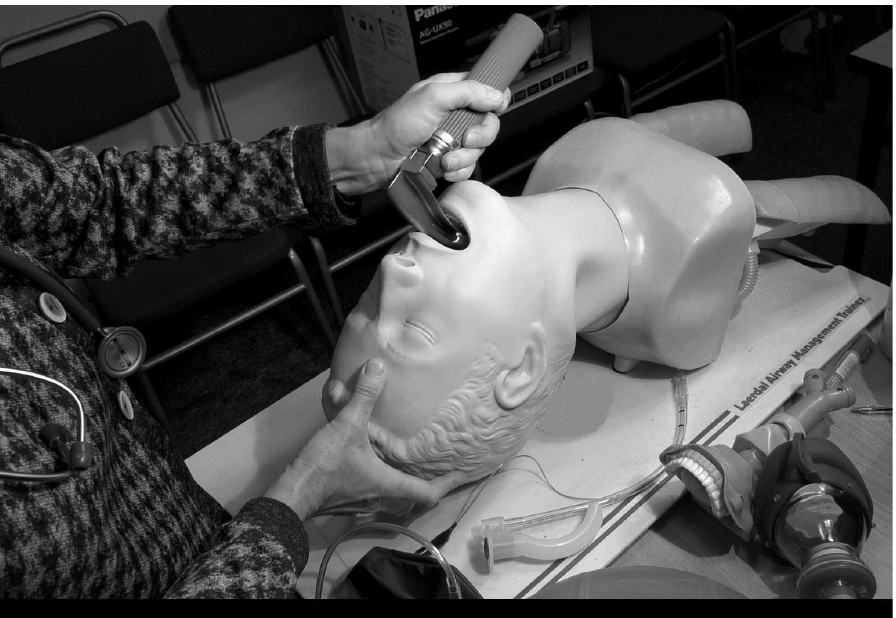
Figure 10. Recording for learning materials at the practical training classroom of the Department of Teaching Anaesthesiology and Intensive Therapy – intubation on a